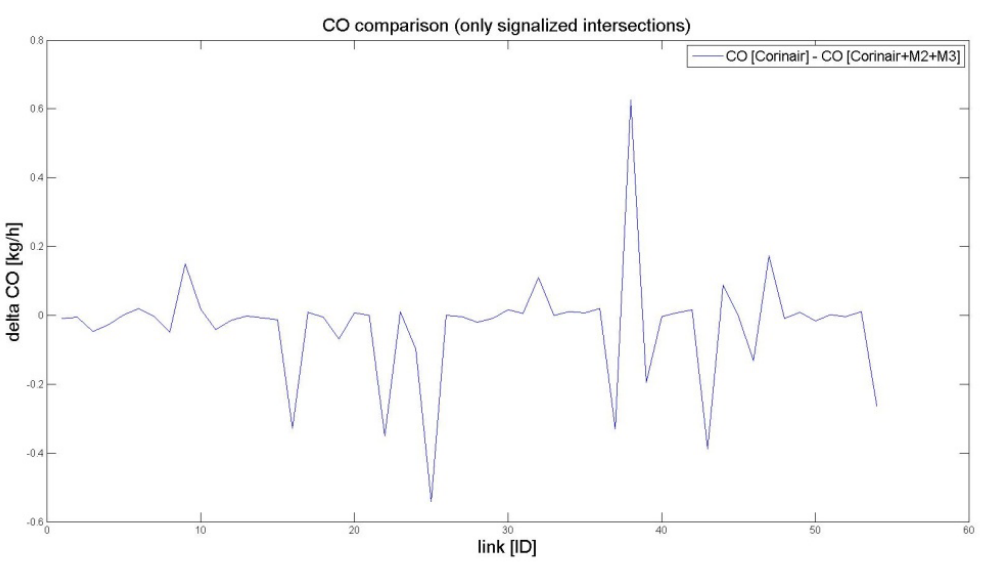
Figure 12. Differences of CO emissions at links approaching signalized intersections using CORINAIR or